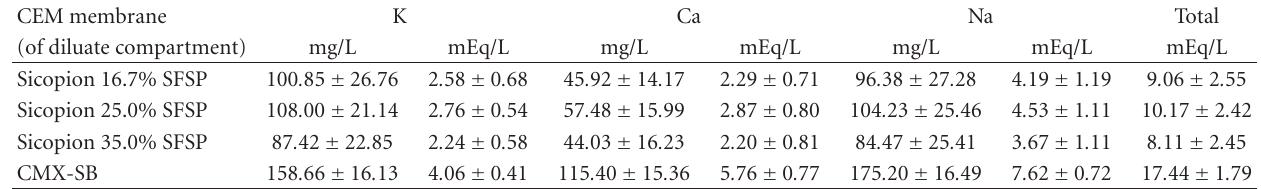
Table 4: Total demineralization rates of the diluate solution in potassium, calcium, sodium, and total cations after 100-minute treatment, in milligrams per liter (mg/L) and milliequivalents per liter (mEq/L). CEM membrane